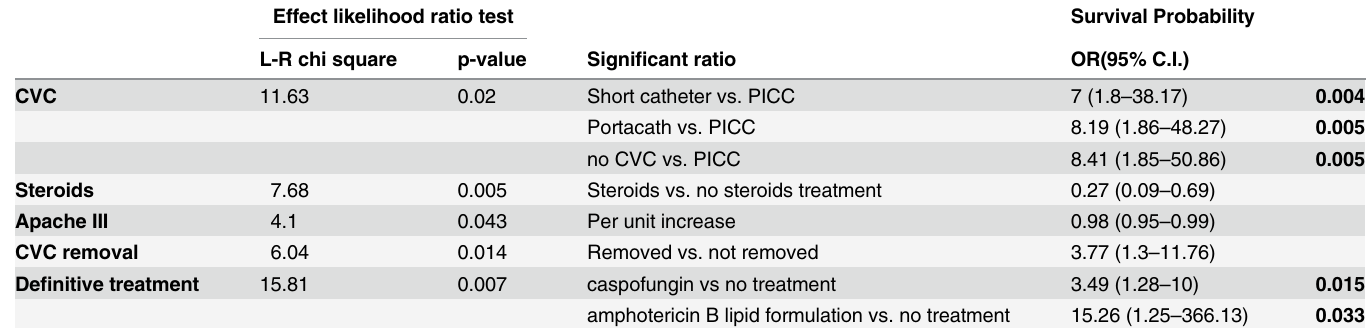
Table 5. Multivariate analysis of risk factors for 30-day